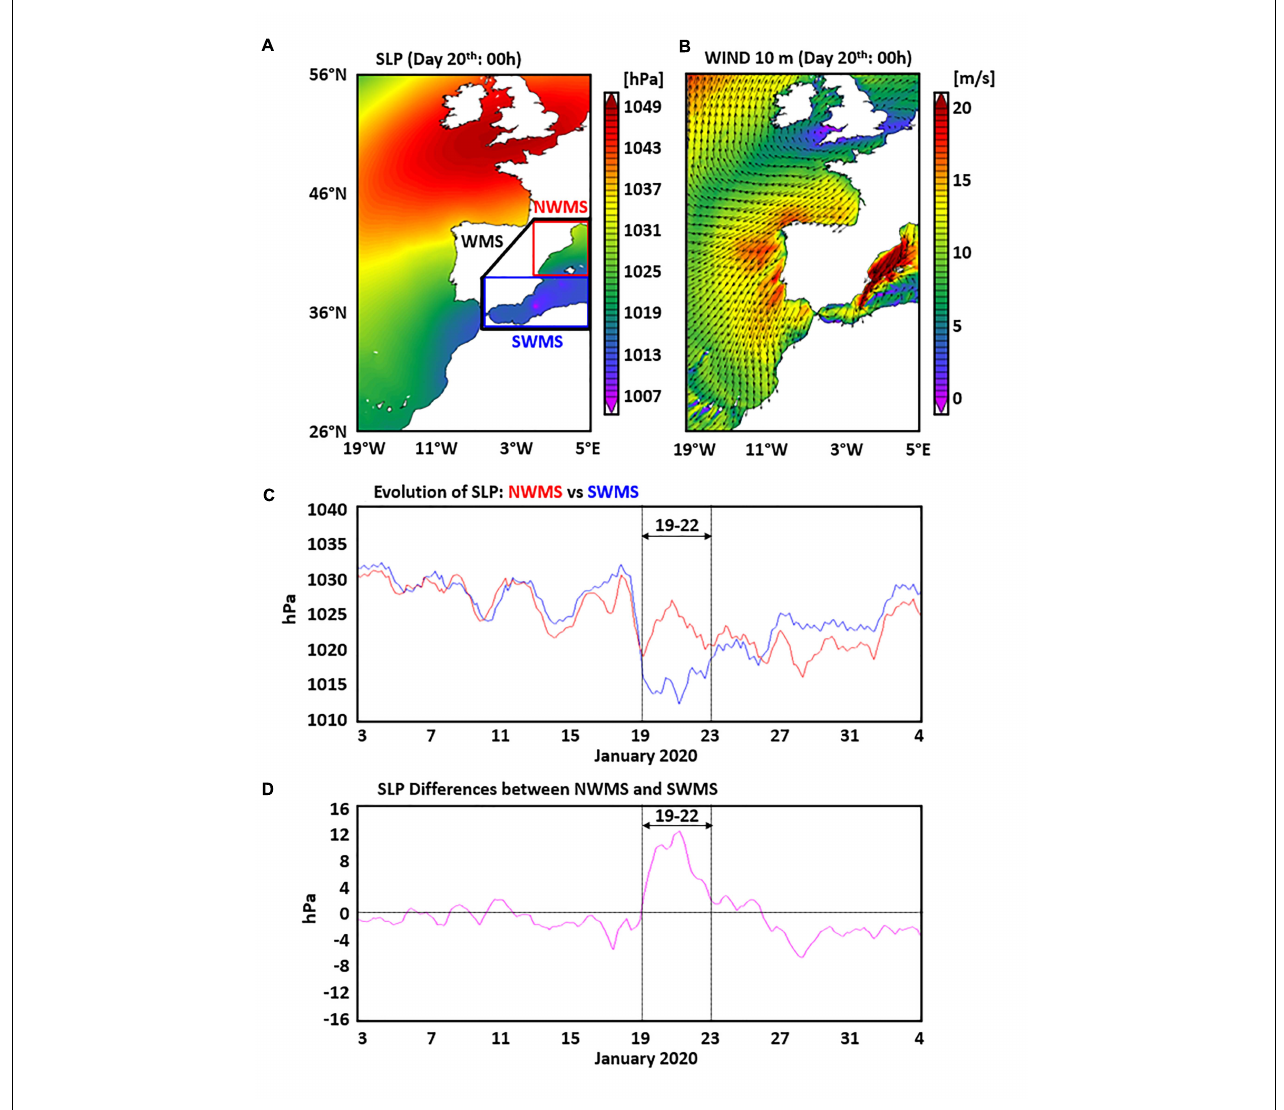
FIGURE 2 | Hourly synoptic patterns (00h CET) of Sea Level Pressure (SLP) (A) and wind at 10 m (B) in the IBI (Iberia-Biscay-Ireland) regional domain during January 20 2020, as provided by the European Center for Medium-Range Weather Forecasts (ECMWF) at 1/8 ◦ horizontal resolution; (C) Blue (red) line represents the 3-hourly time series of SLP, spatially-averaged over the northwestern (sourthwestern) Mediterranean sea subbasin, denoted as NWMS (SWMS) in panel (A) and comprised between 1 ◦ W-5 ◦ E and 39 ◦ N-44 ◦ N (6 ◦ W-5 ◦ E and 35 ◦ N-39 ◦ N); (D) Time series of SLP differences between the NWMS and SWMS sub-basins.